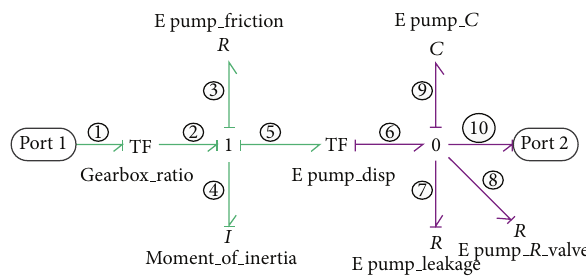
Figure 5: Bond graph model of the direction